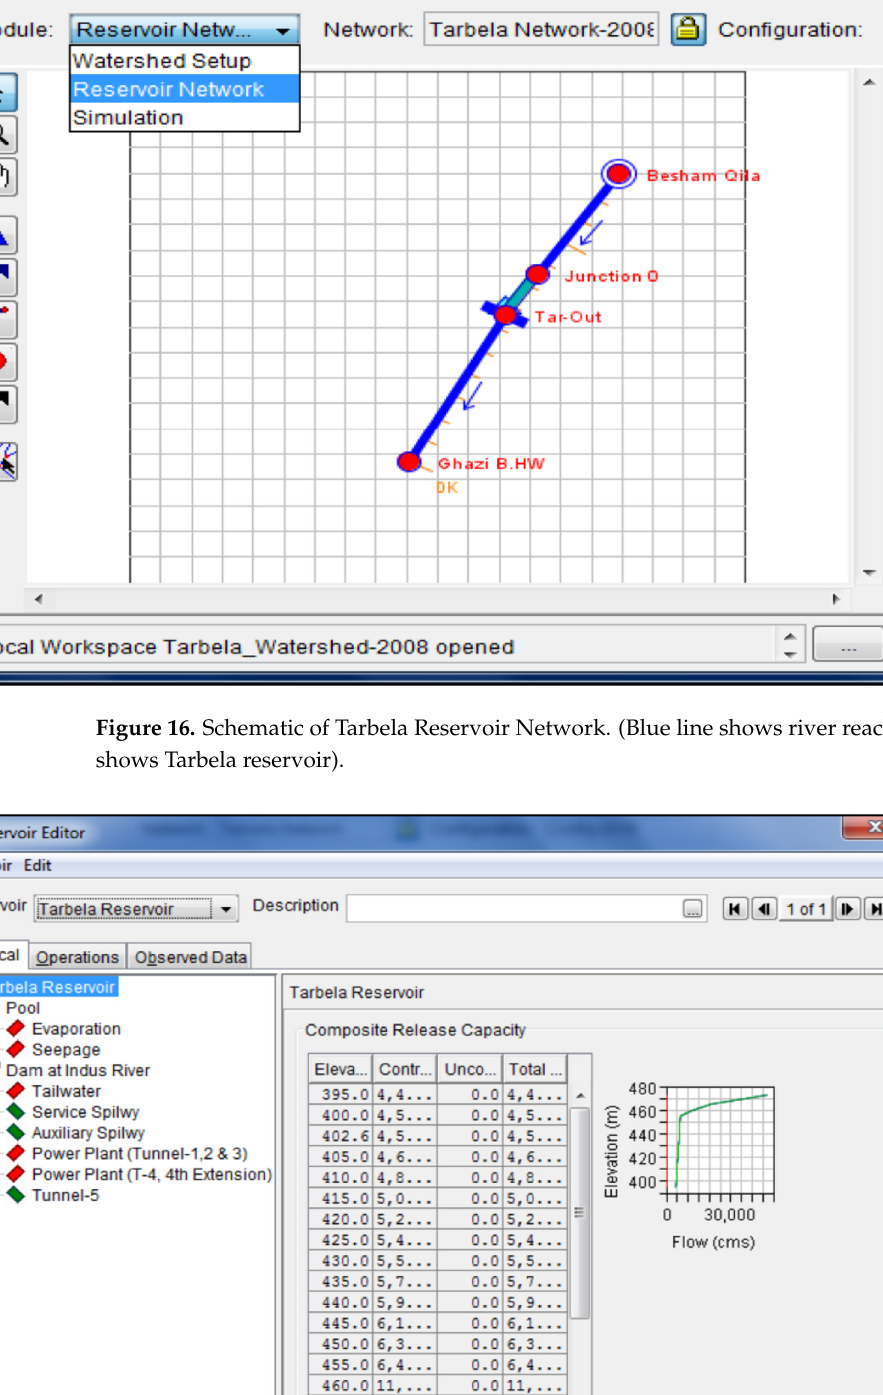
18 of 42 Figure 15. Input Screen of HEC-ResSim for Modelling Tarbela.(Blue line shows river reach while yellow part shows Tarbela reservoir) The main objective of the Watershed Setup module was to give a setup to create the watershed. The watershed setup module is the part of other HEC generations like HEC- RAS, HEC-ResSim, HEC-FIA and HEC-HMS. The Tarbela Reservoir watershed is related to the alignment of upstream and downstream reaches of the Indus River and the Tarbela Reservoir in the watershed. The watershed setup module includes all the streams, projects (reservoirs), time-series locations, impact areas, computation points and hydraulic and hydrologic data points for the watershed area. The final configuration of all these elements is used to generate the watershed framework. The Reservoir Network is the second step and is the most complicated module of the software. In the Reservoir Network module, the river and reservoir schematic diagram shows the operational elements and the physical parts of model, and the new alternatives can be developed so that they can analysed in the simulation. Then the river reaches and the remaining network elements were connected to accomplish the network scheme. The operational and physical data for each element of the network were incorporated on fin-